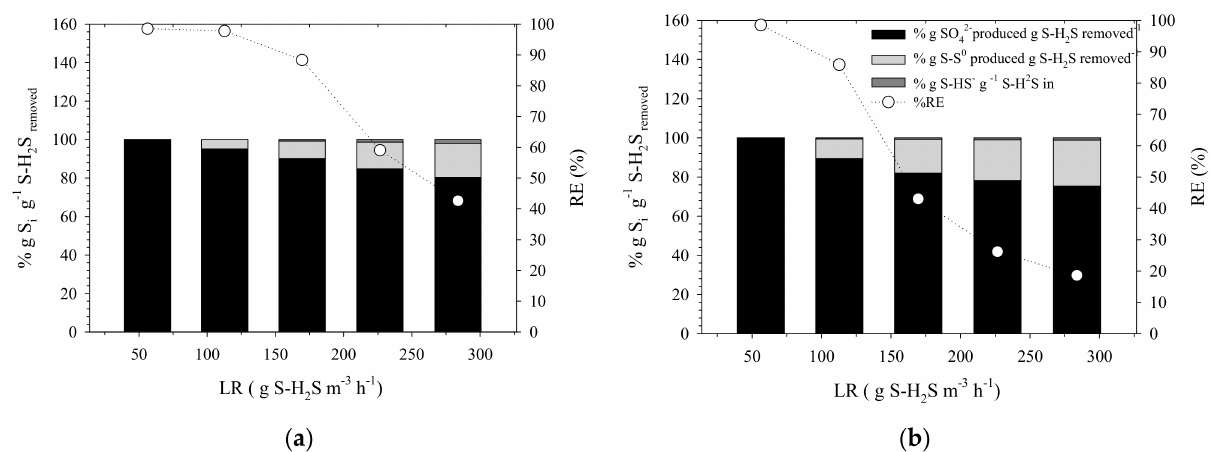
Figure 4. Sulfur species selectivity as function of H 2 S loading rate (LR) step-wise changes of ( a ) H 2 S inlet concentration and ( b ) biogas flowrate under Open-Loop